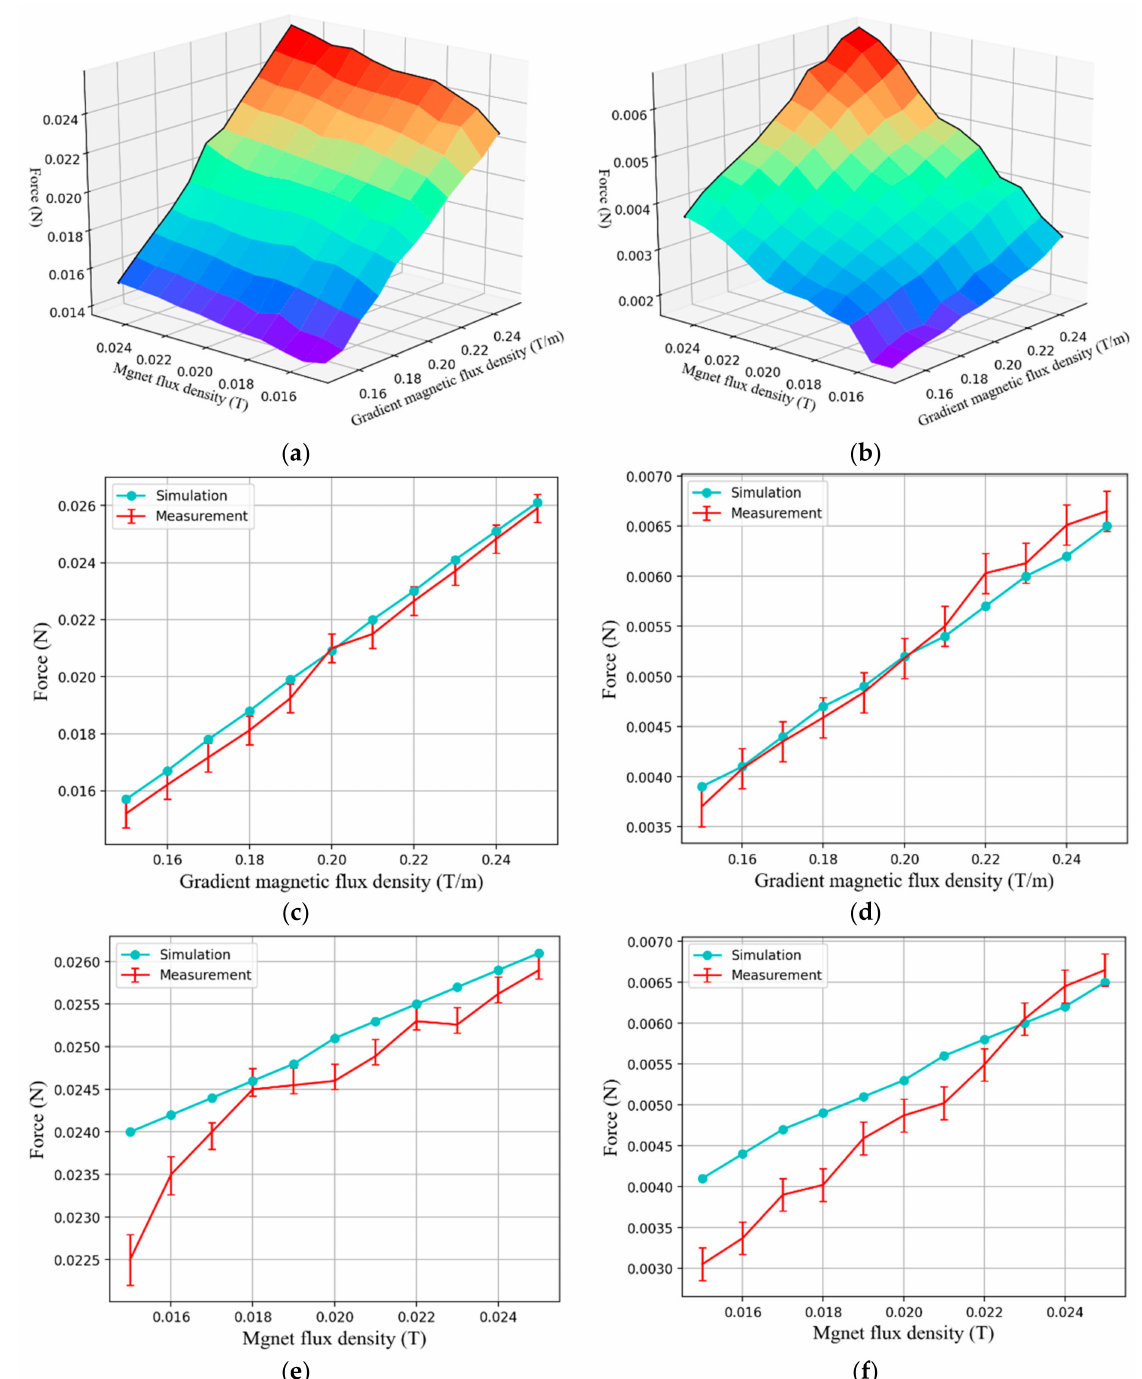
Figure 9. Result of propulsion force measurements. Measured propulsion force of the driving capsule ( a ), and functional capsule ( b ). Relationship between the propulsion force and gradient magnetic field under a fixed magnetic flux density for the driving capsule ( c ), and for the functional capsule ( d ). Relation between the propulsion force and magnetic flux density under a fixed gradient magnetic field for the driving capsule ( e ), and for the functional capsule ( f